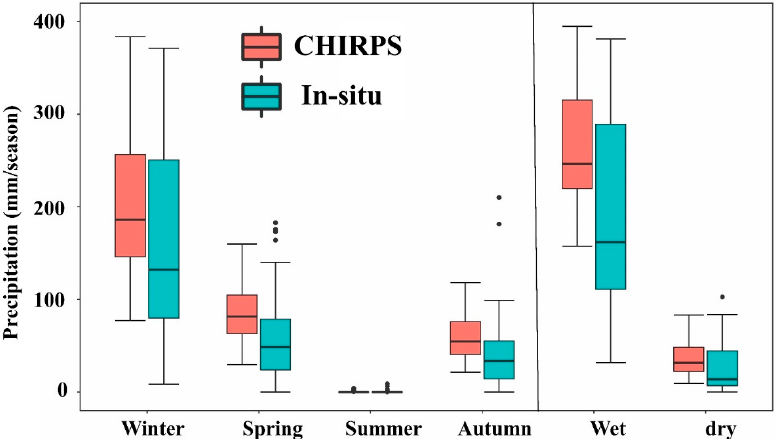
Figure 7. Seasonal boxplot comparison between in-situ and CHIRPS precipitation in the Barada Basin. Wet is the accumulation of rainy months from October to the end of March. Dry is the accumulation of dry months from April to the end of September.